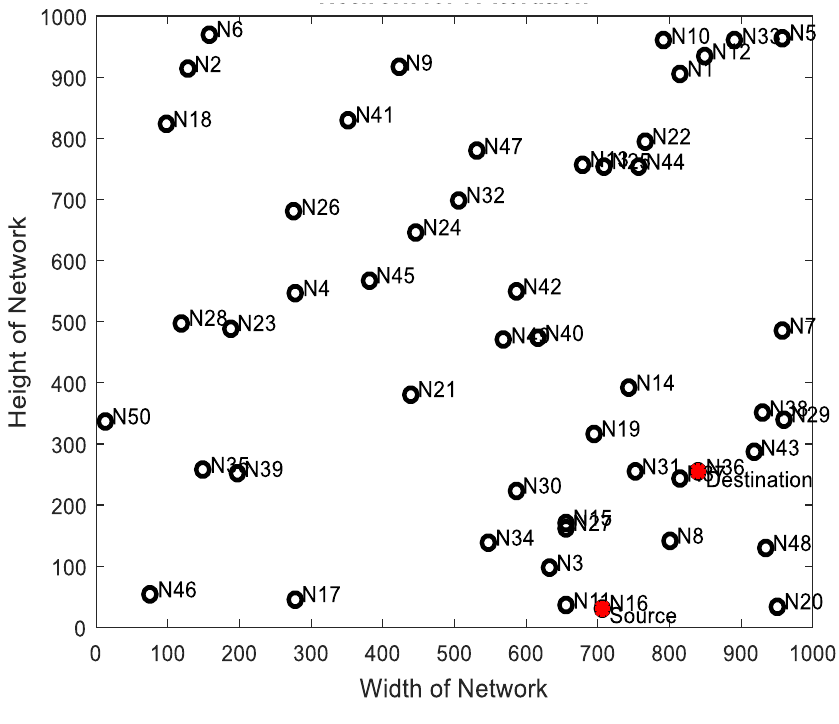
Figure 3. Node deployment.